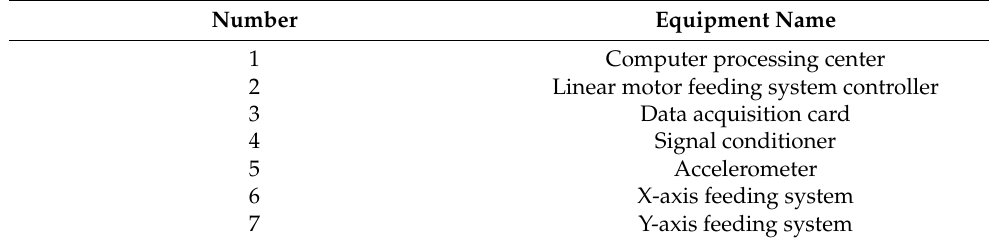
Table 2. Numbers and names of acquisition